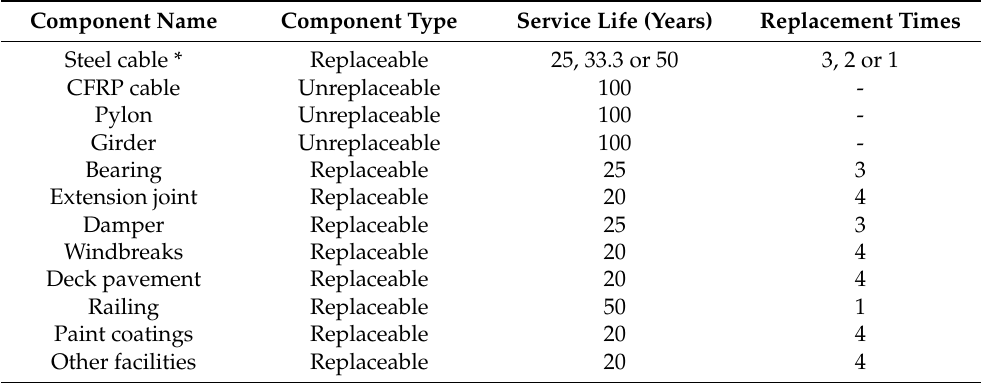
Table 8. Classification of bridge components and their service